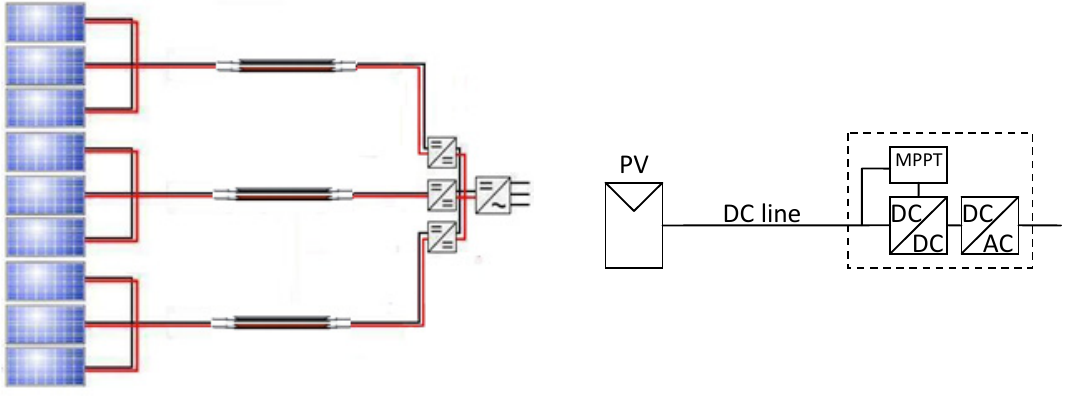
Figure 2. Layout of PV plant with double-stage concentrated conversion ((D)